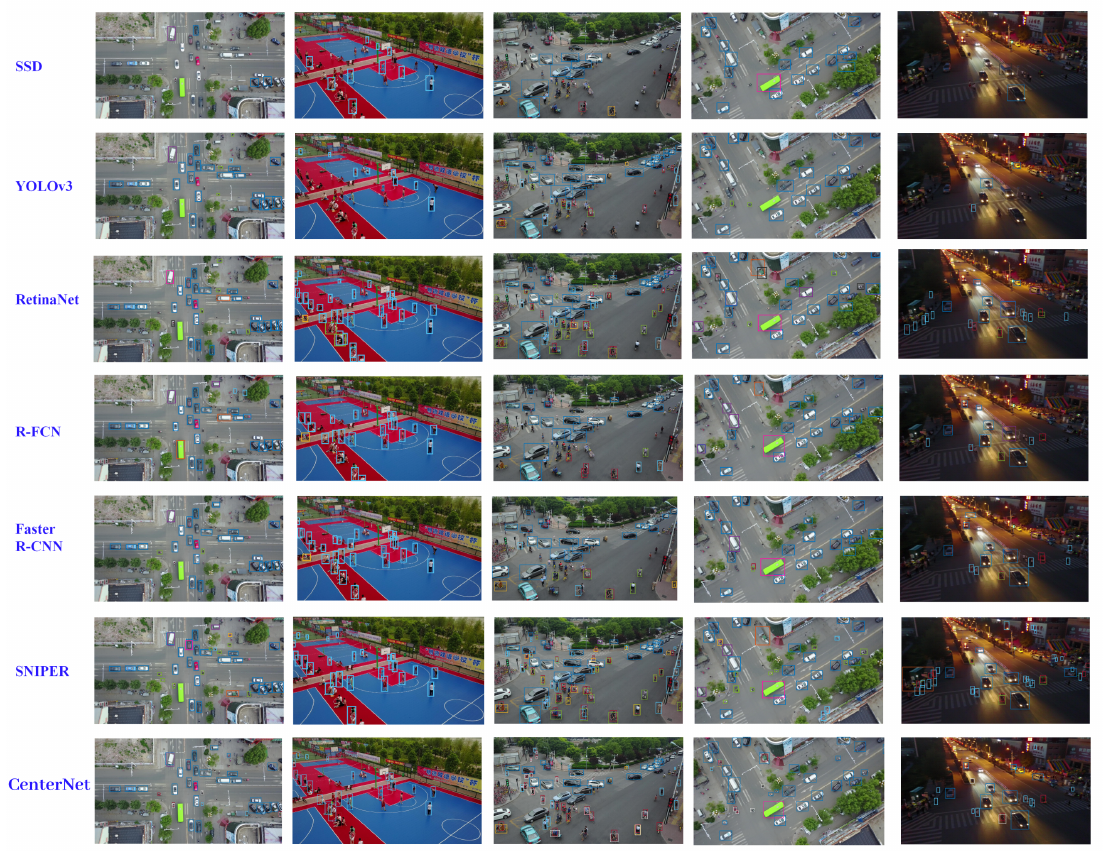
Figure 6. Visualization results of different object detection methods. Color legend: car, truck, bicycle, van, moto, pedestrian, people, bus, tricycle, awning-tricycle. Best view in high 400% resolution.